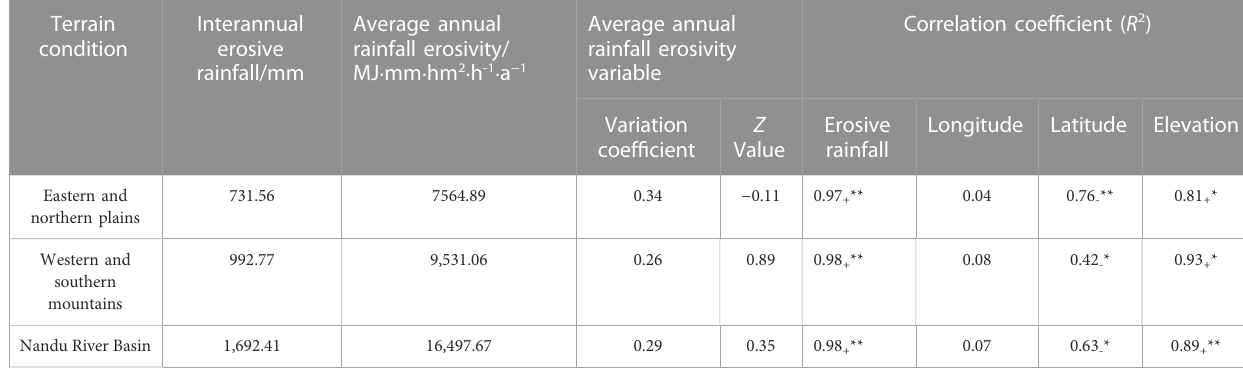
TABLE 3 Rainfall erosivity and in fl uencing factors under different terrain conditions in the Nandu River Basin. Terrain